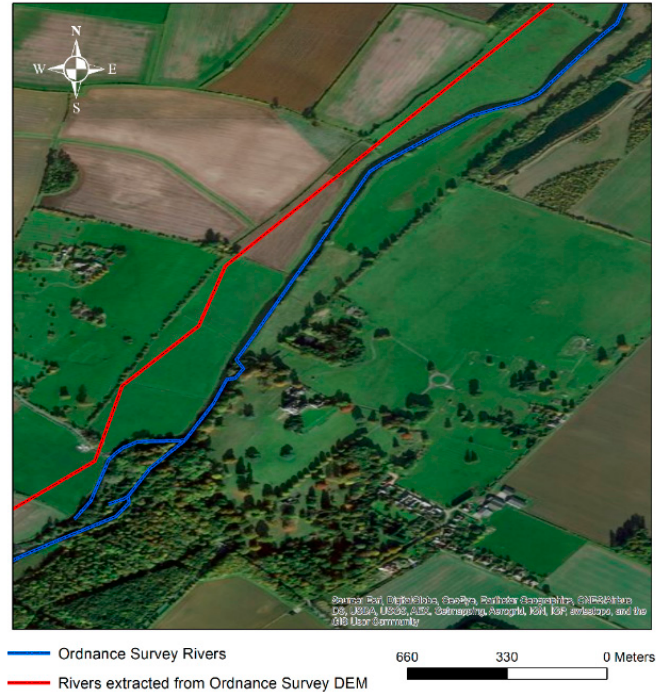
Figure 5. A drainage network of Great Britain extracted from the Ordnance Survey web page (blue colour) and a drainage network extracted from Ordnance Survey 50 m resolution DEM.